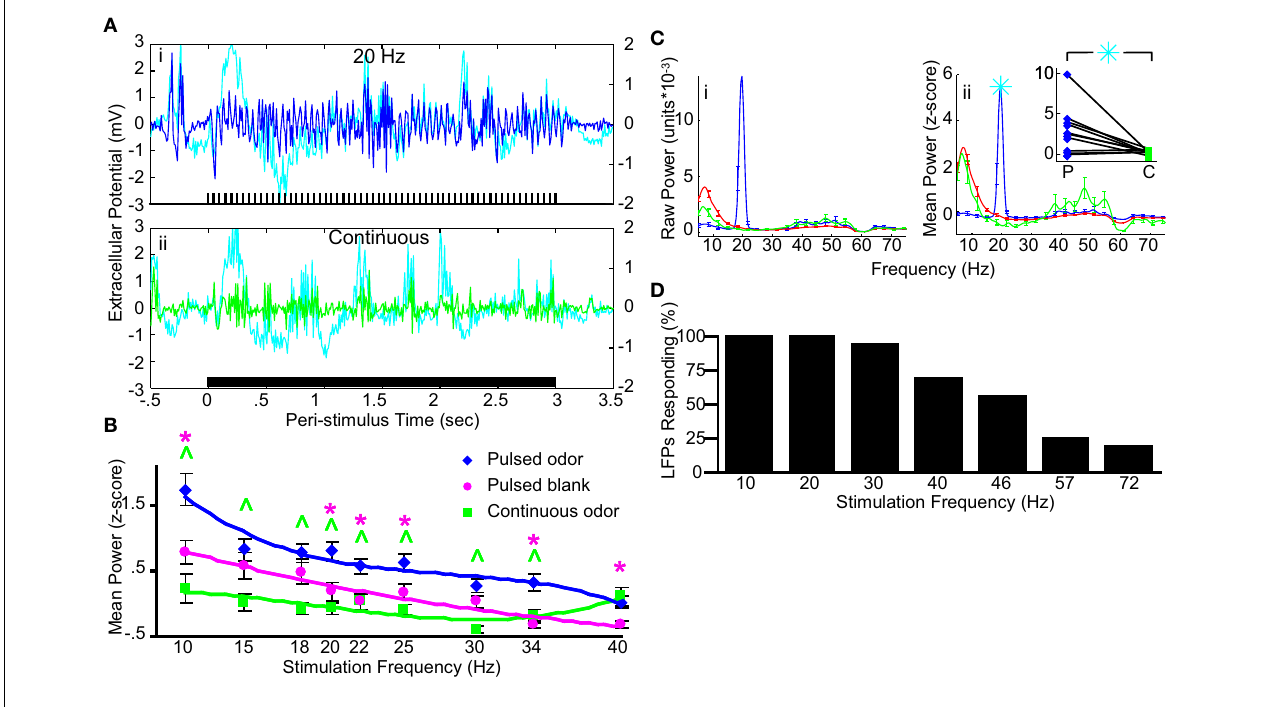
asterisk in (ii) indicates a peak in the PSD, which is signifi cantly higher than the corresponding value elicited by continuous stimulation ( p < 0.05). This PSD peak of the neural response is located at the same frequency that was used for pulsing the odor. Error bars indicate SEM and are shown in 3 Hz intervals. Inset in (ii) compares the normalized PSD values for all trials at the stimulation frequency of 20 Hz in response to pulsed (blue diamonds) or continuous (green squares) odor presentation. Lines connect stimulations of identical odors. X -axis indicates pulsed (P) or continuous (C). Asterisk is same asterisk in main fi gure. (D) Percentage of LFPs (16 total, 4 animals) that respond signifi cantly to pulsing ( p < 0.05) by stimulus frequency using the criteria shown in (C) . The drop